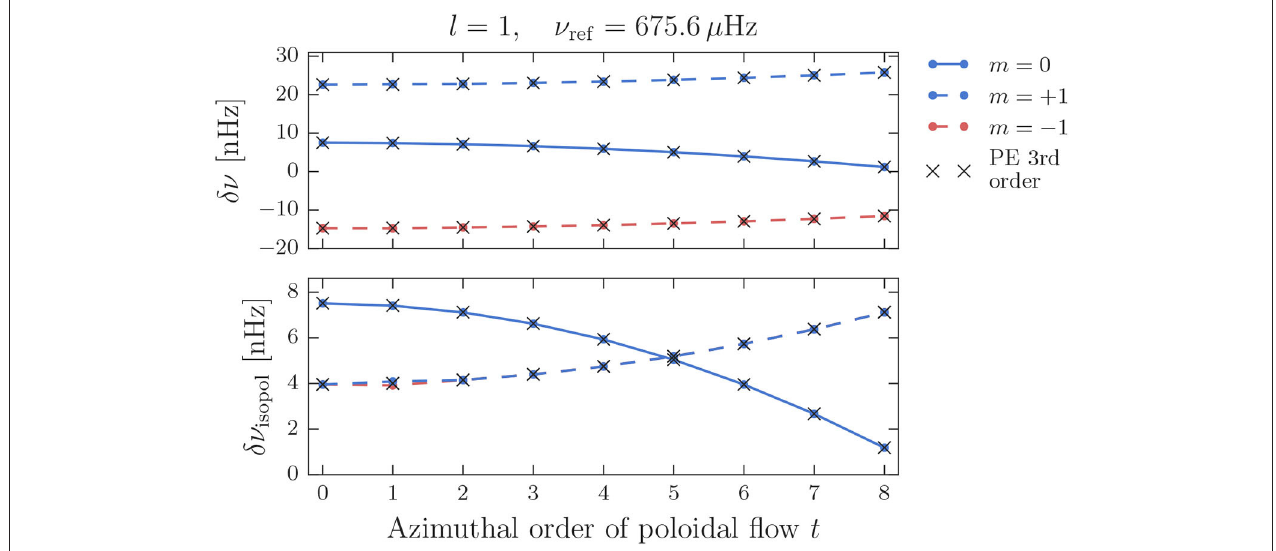
FIGURE 6 | Frequency shifts in the co-rotating frame for the almost pure p-type l poloidal flow of s 8 and different values of t . (Lower) Isolated frequency shifts due to the poloidal =